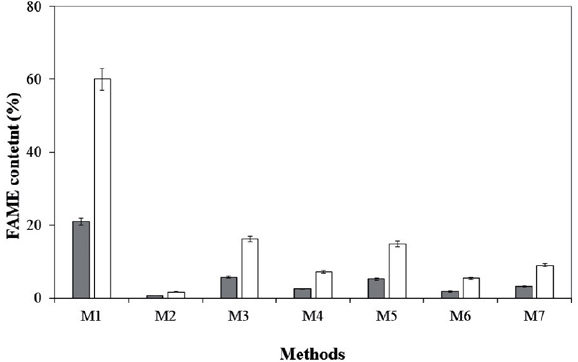
Fig. 3. Total FAME fraction in total lipids (% w/w total lipids, open bars) or in the biomass (% wt, solid bars) of P. tricornutum from seven independent transesterification methods (p < 0.05; n = 3). Note. wt: percentage in relation to freeze-dried